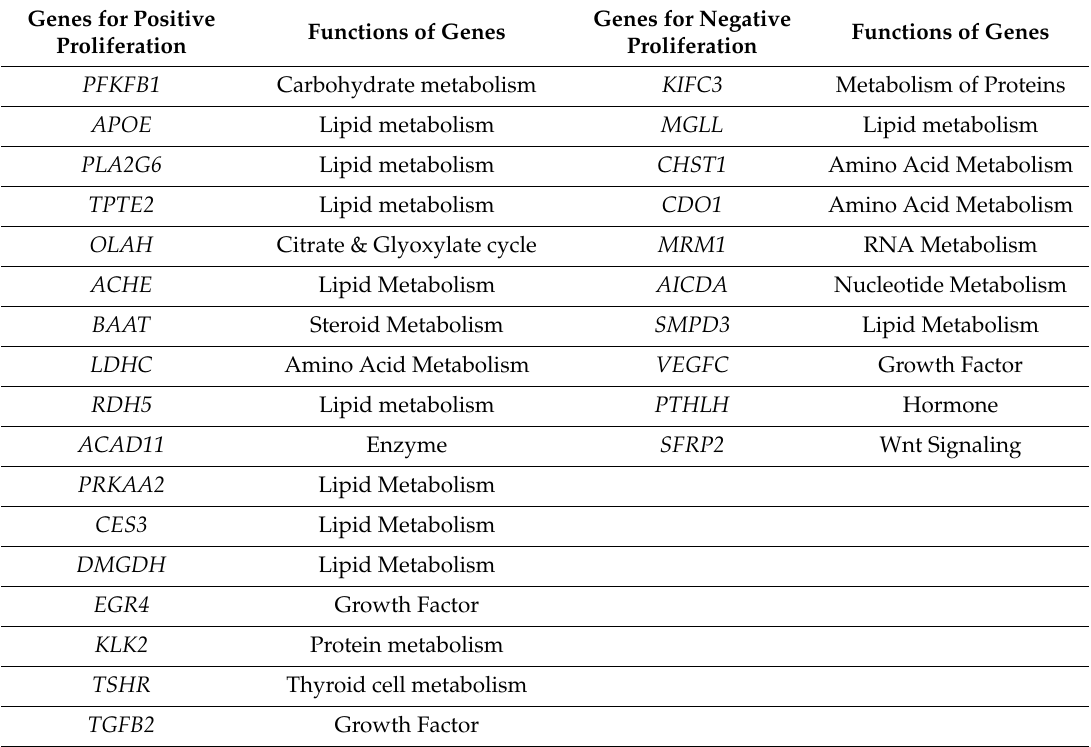
Table 4. The functions of metabolic genes involved in positive and negative proliferation that have large change in their expression levels. Data for up- and down-regulated genes were obtained from RNA sequencing of samples supplemented at the no cytokine, 000, 200, 020, and 002 conditions. Genes were identified using the program Metacore and referenced with several databases, including the Biological Magnetic Resonance Data Bank and the Mammalian Metabolic Enzyme Database. Genes for Negative Genes for Positive Functions of Functions of Genes Proliferation Proliferation